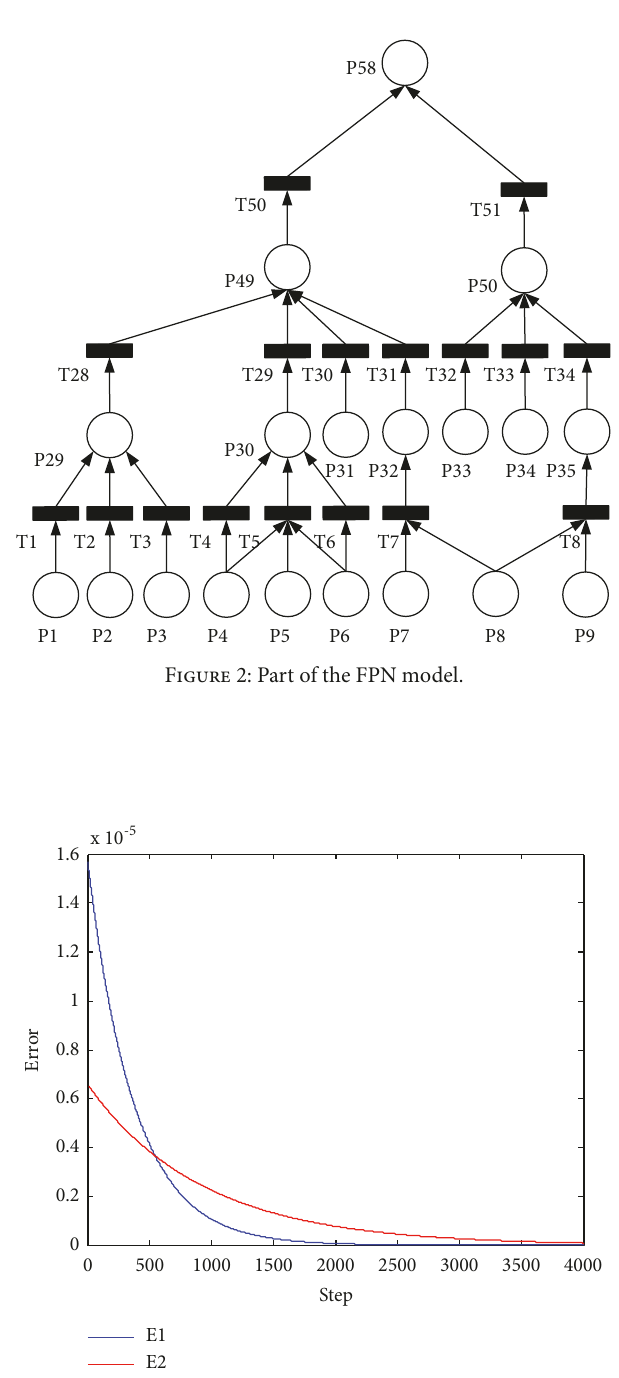
Figure 3: Adjustment curve of square error